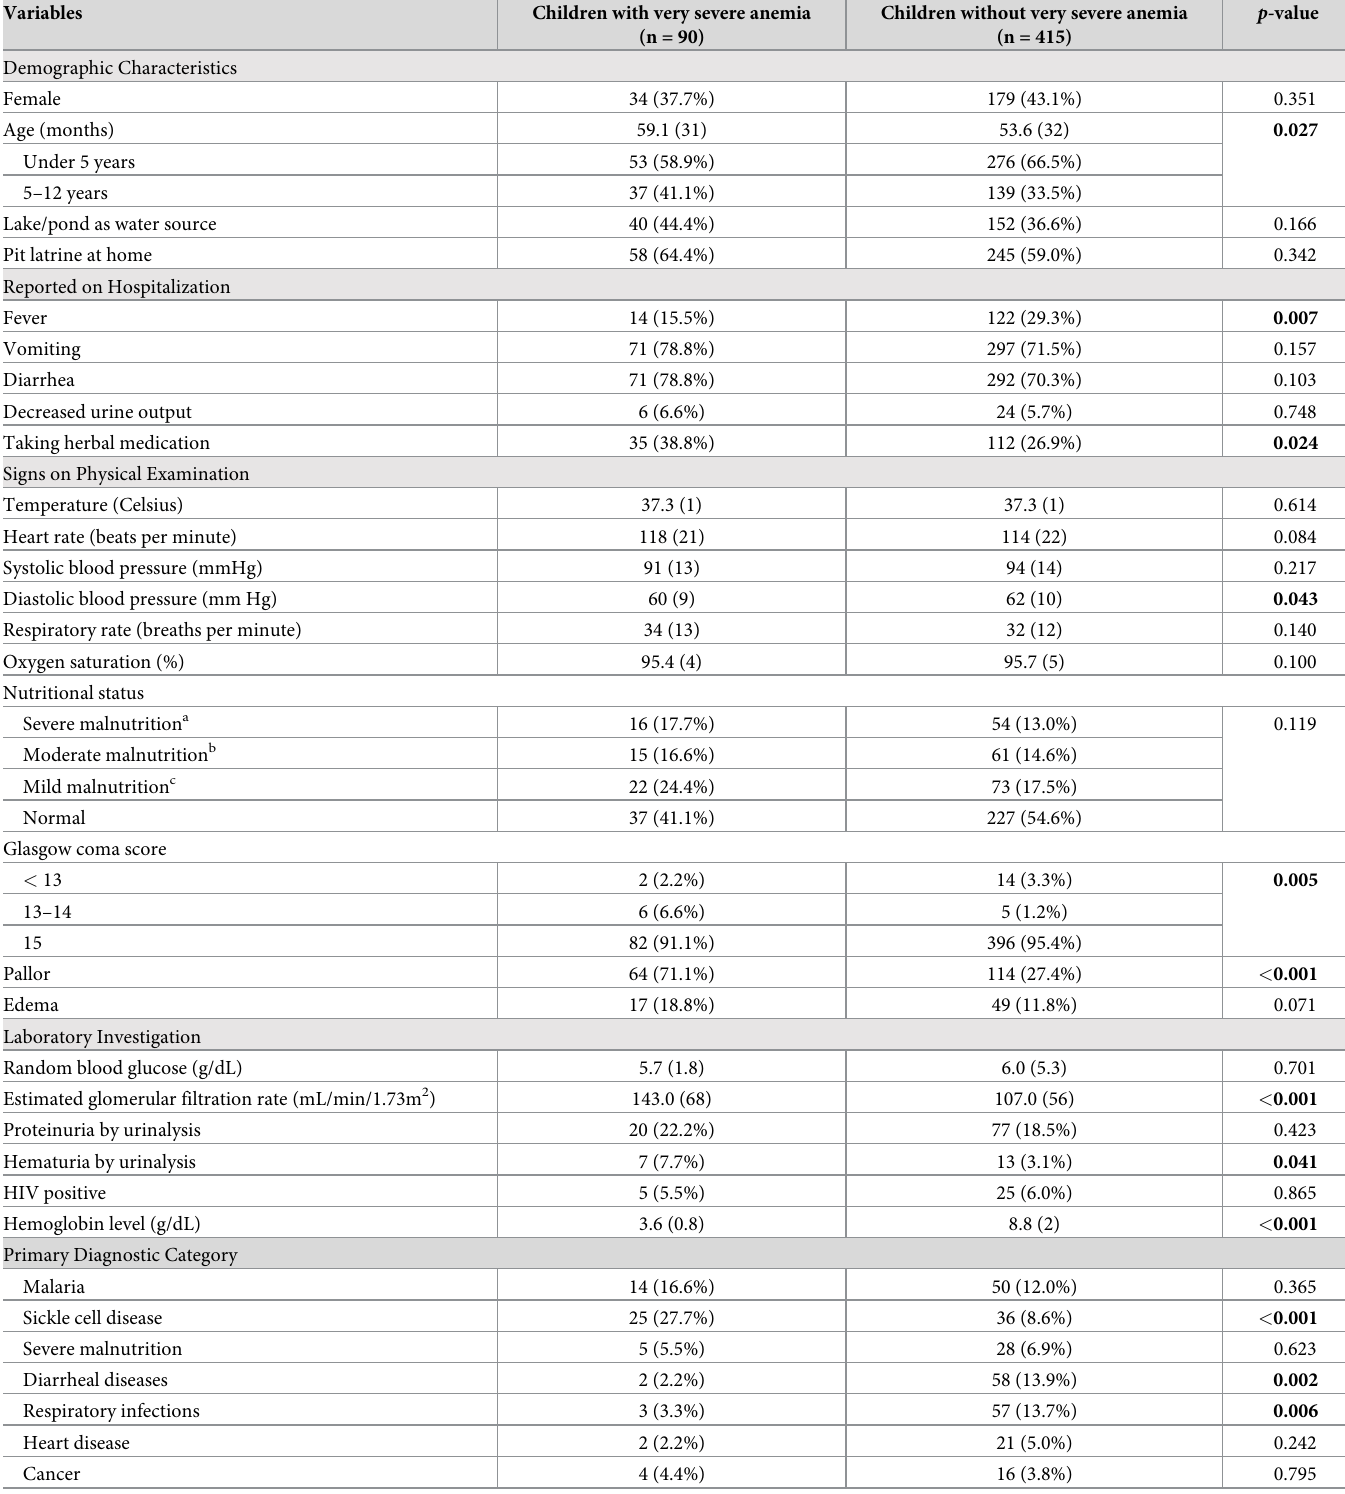
Table 1. Baseline characteristics of children with very severe anemia and without very severe